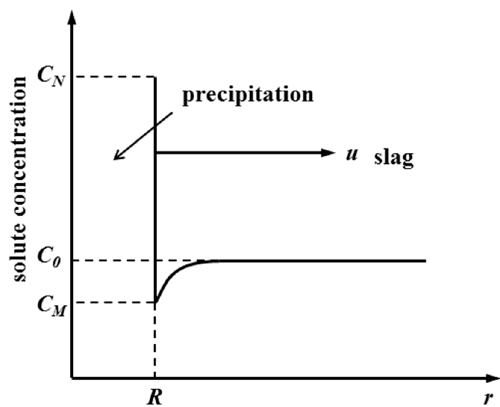
Figure 6. Concentration distribution of the solute atoms in slag during spinel crystal growth. C 0 represents the average concentration of solute atoms in the matrix, C M represents the concentration of solute atoms in the matrix side at the crystal interface, C N represents the concentration of solute atoms in the crystal side at the crystal interface, and u represents the growth rate of the crystal.